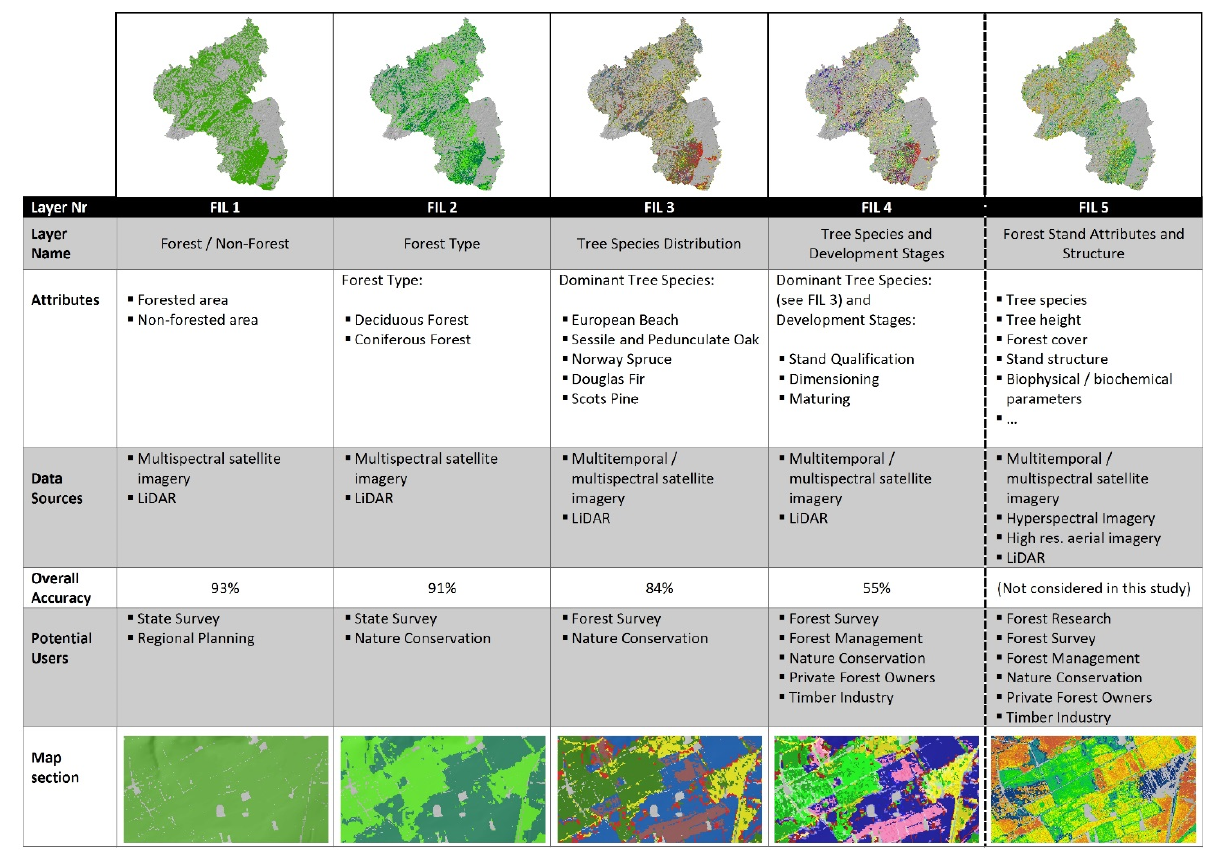
Figure 9. Conceptual layout of operational forest information layers derived of the conclusion of this